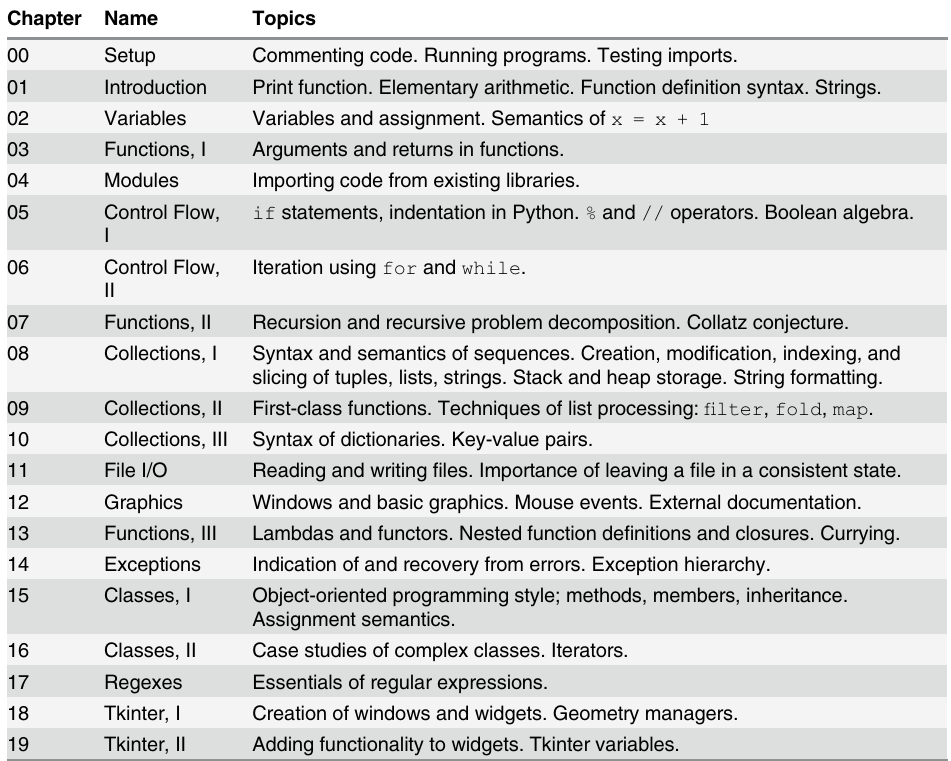
Table 1. Overview of the Supplemental Chapters (S1